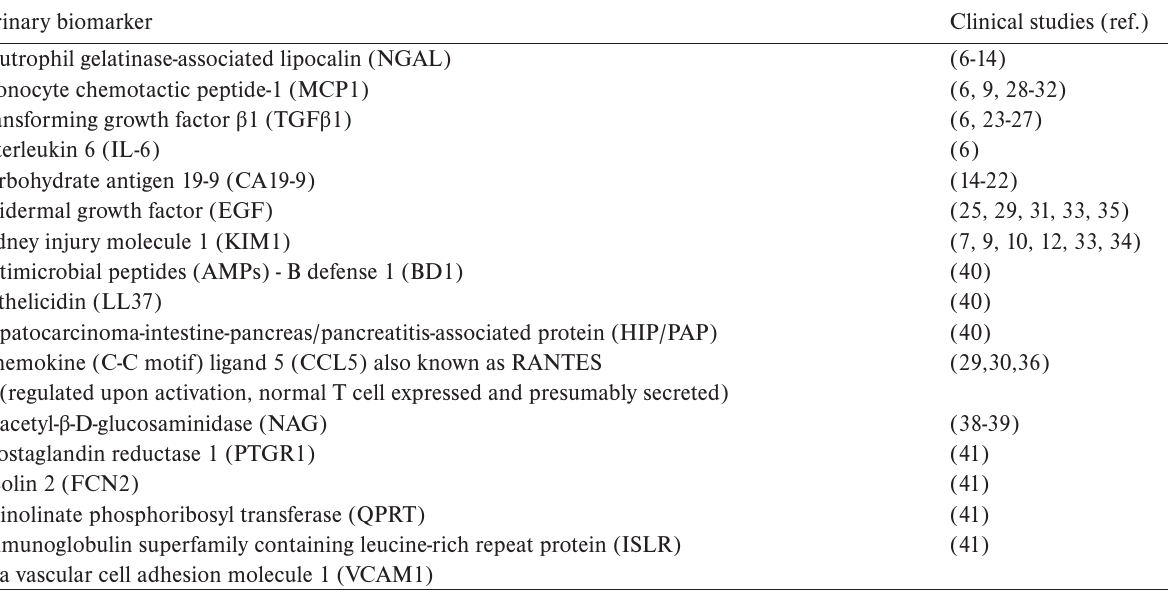
Table 1. Biomarkers clinically studied in UPJ